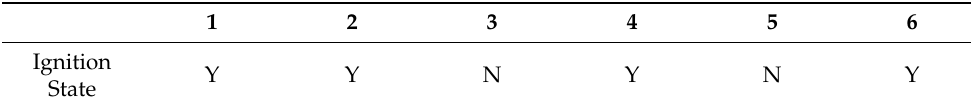
Table 9. The ignition state of the sample in the